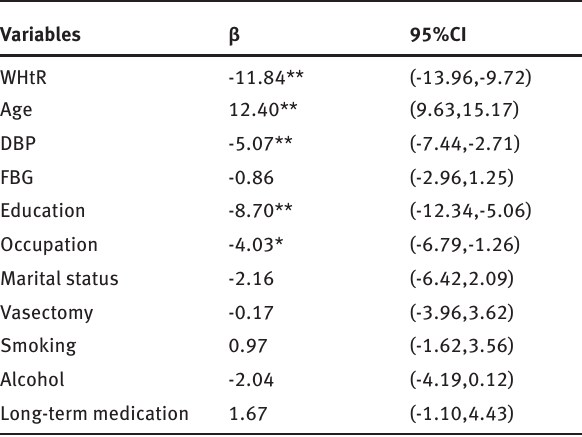
Table 3: Multiple linear regression of factors associated with SHBG level.